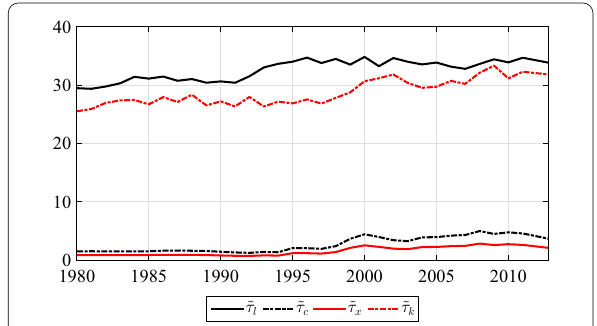
Fig. 9 Evolution of taxes (1980Q1–2012Q4). ˜ τ l is the marginal tax rate on labour, ˜ τ c is the average consumption tax rate, ˜ τ x is the average tax rate on investment, and ˜ τ k is the marginal tax rate on capital